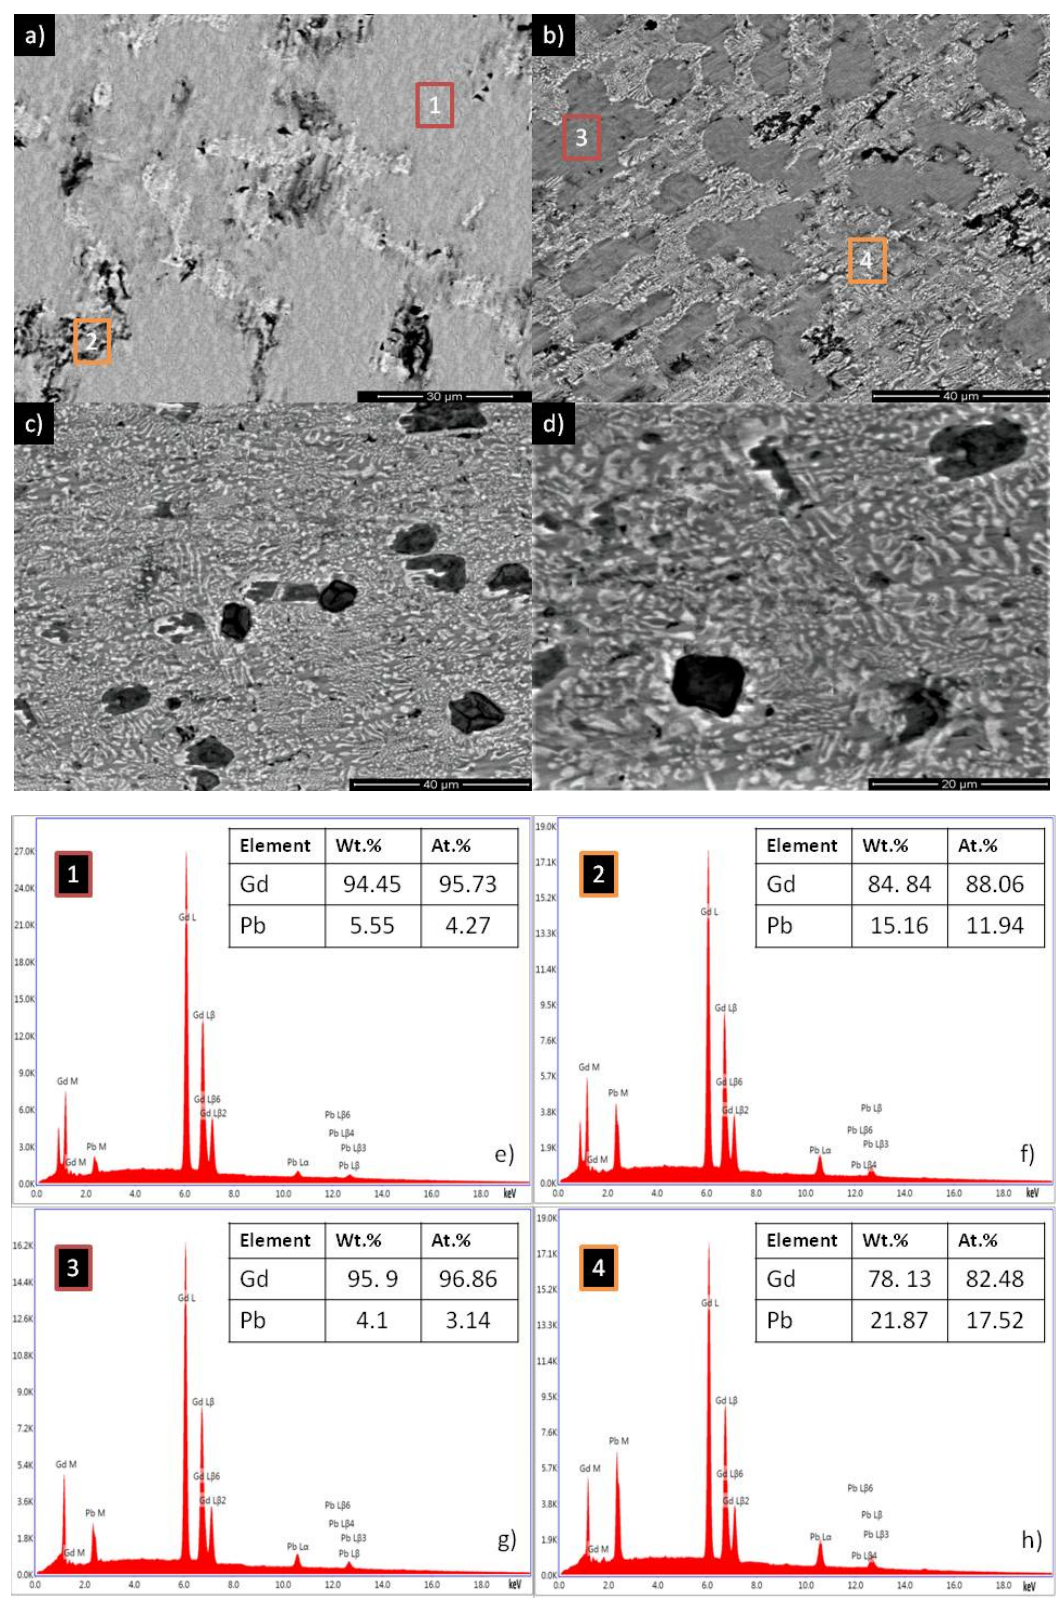
Figure 3. SEM microstructure of: ( a ) Gd 95 Pb 5 , ( b ) Gd 90 Pb 10 , ( c ) Gd 85 Pb 15 and ( d ) Gd 80 Pb 20 . The results of the EDX analysis of the Gd 95 Pb 5 sample ( e ) and ( f ), while ( g ) and ( h ) are for the Gd 90 Pb 10 alloy. Table 2. Chemical composition of recognized phases in all studied alloys.